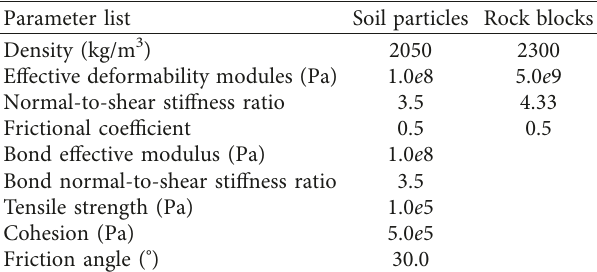
Figure 5: Random models of SRM with different rock block proportions (a) and inclinations (b). Table 1: Numerical parameters of soil particles and rock